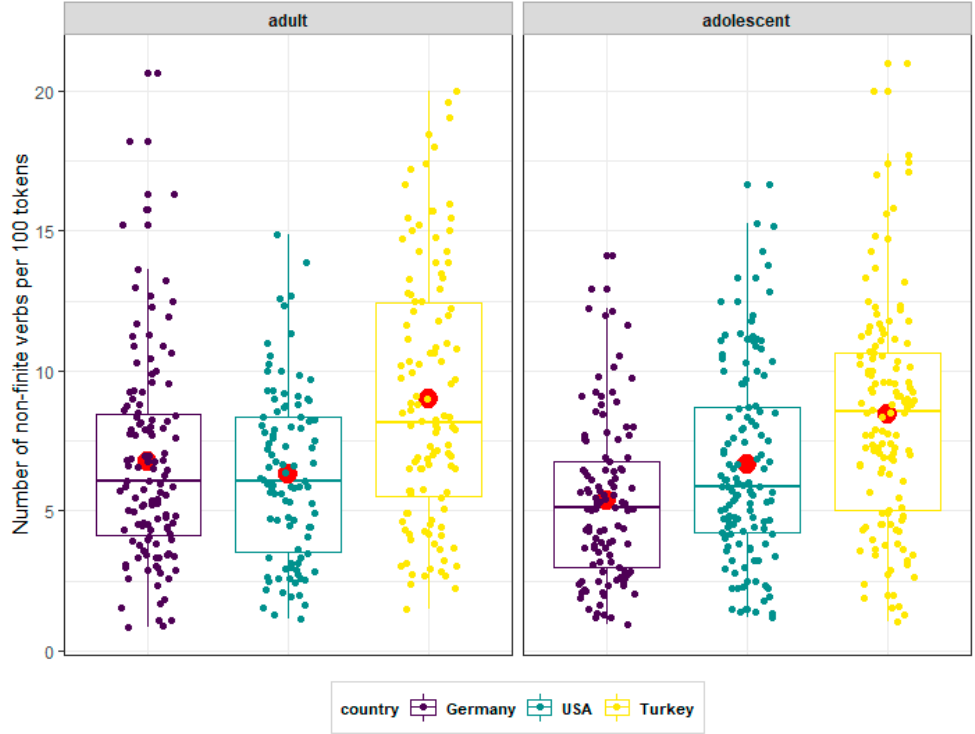
Figure 1. Box plots representing non-finite verbs per 100 tokens with the focus on age. Each data-point gives one speaker’s use of non-finite verbs per 100 tokens.